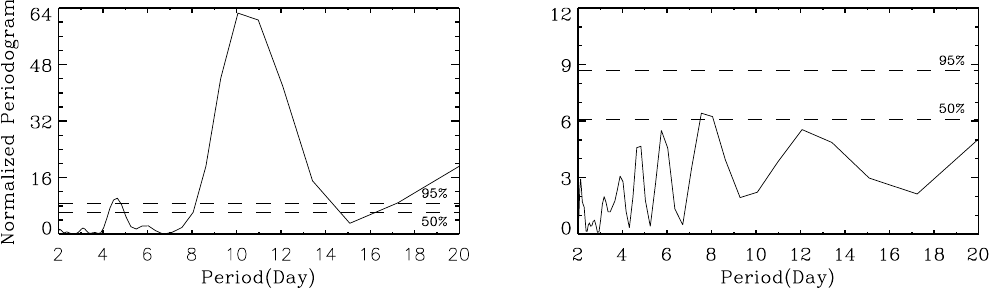
Fig. 18. Normalized Lomb-Scargle periodograms of the magnitude (left) and height (right) of the tropospheric jet in January 2007. The dashed horizontal lines denote the confidence levels of 95% and